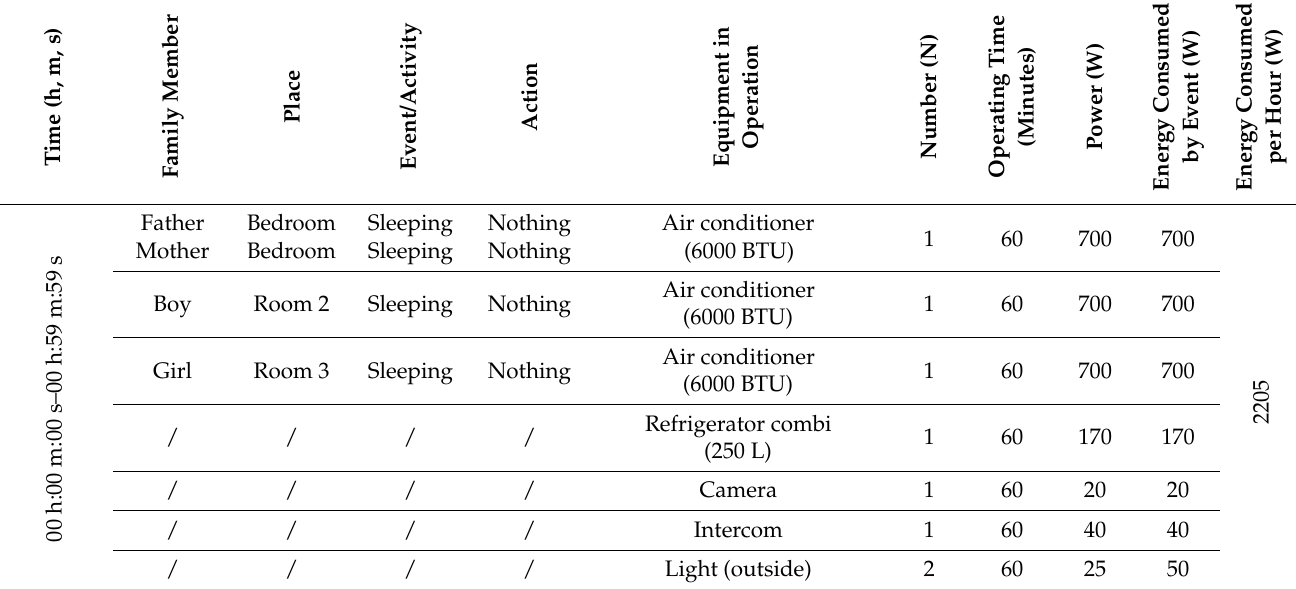
Table 7. Energy consumption scenario in the period: 01 h: 00 m: 00 s to 01 h: 59 m: 59